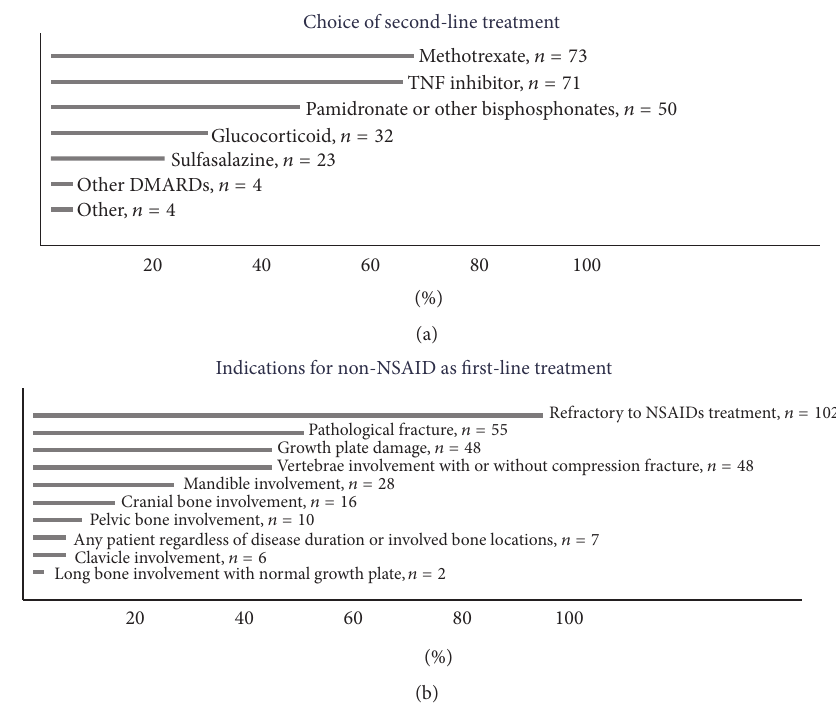
Figure 4: (a) Frequency of use for non-NSAID as second-line treatment; (b) clinical features indicating non-NSAID as first-line treatment.